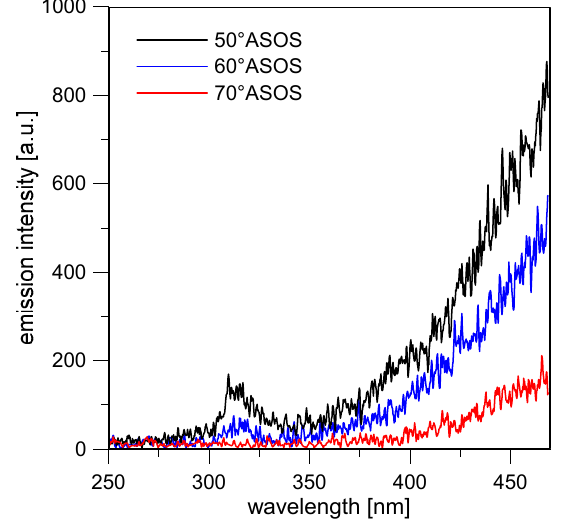
Figure 18. UV-visible spectra detected in three regions of the combustion chamber at 23 CAD ASOS ( a ) and 38 CAD ASOS ( b ) for λ = 1.0. Energies 2017 , 10 , 1337